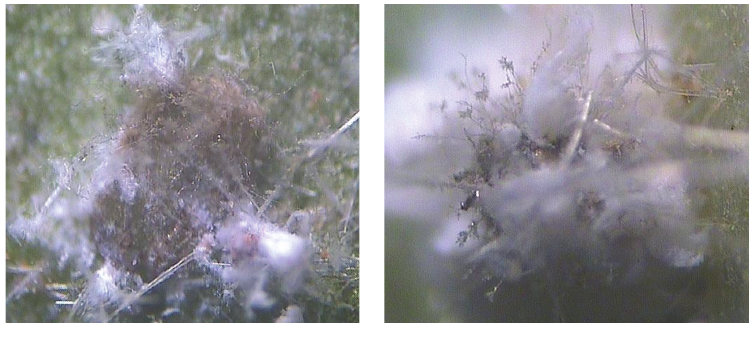
Figure 1: Infected cadavers of A. dispersus by entomopathogenic